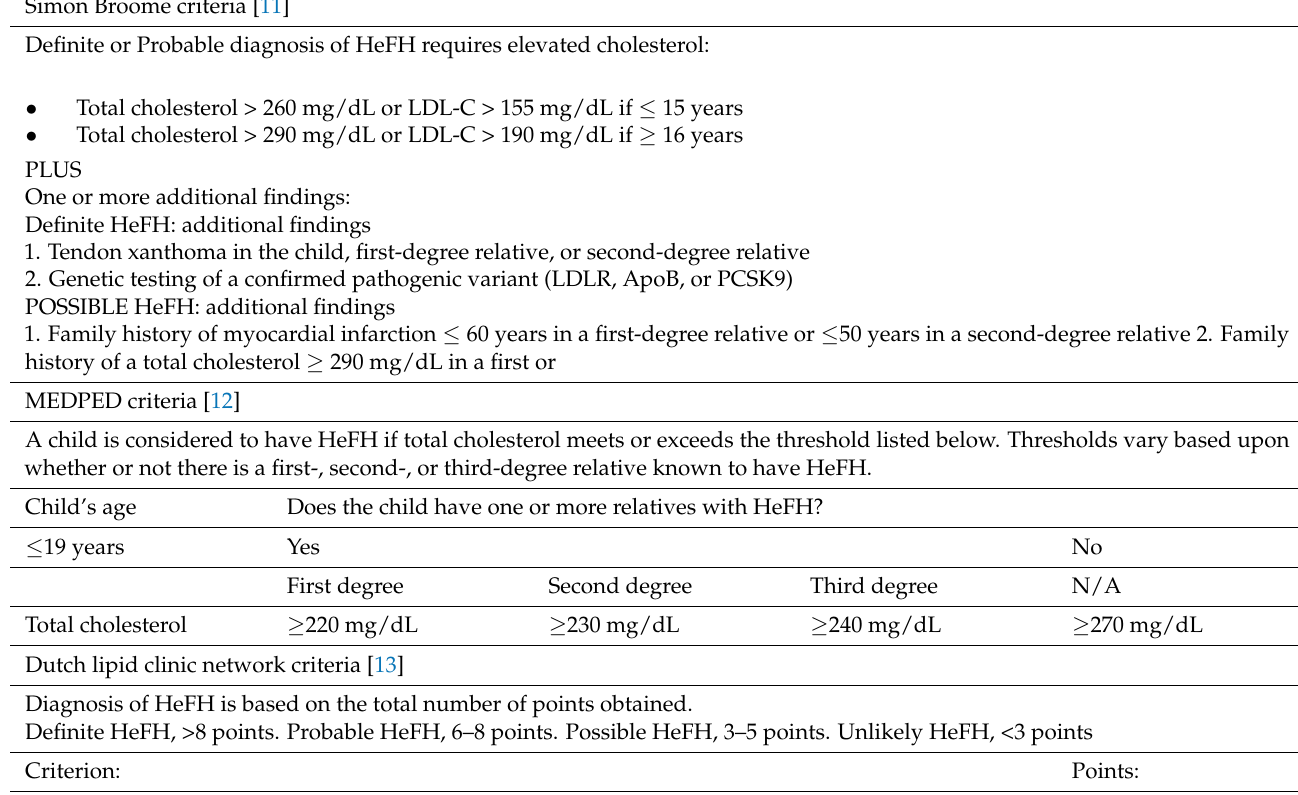
Table 2. Diagnostic criteria for heterozygous familial hypercholesterolemia in children [10]. Reprinted with permission from Peterson AL, McNeal CJ, and Wilson DP. Prevention of atherosclerotic cardio- vascular disease in children with familial hypercholesterolemia. Curr Atheroscler Rep. 2021 Aug 27;23(10):64. 2021, Springer